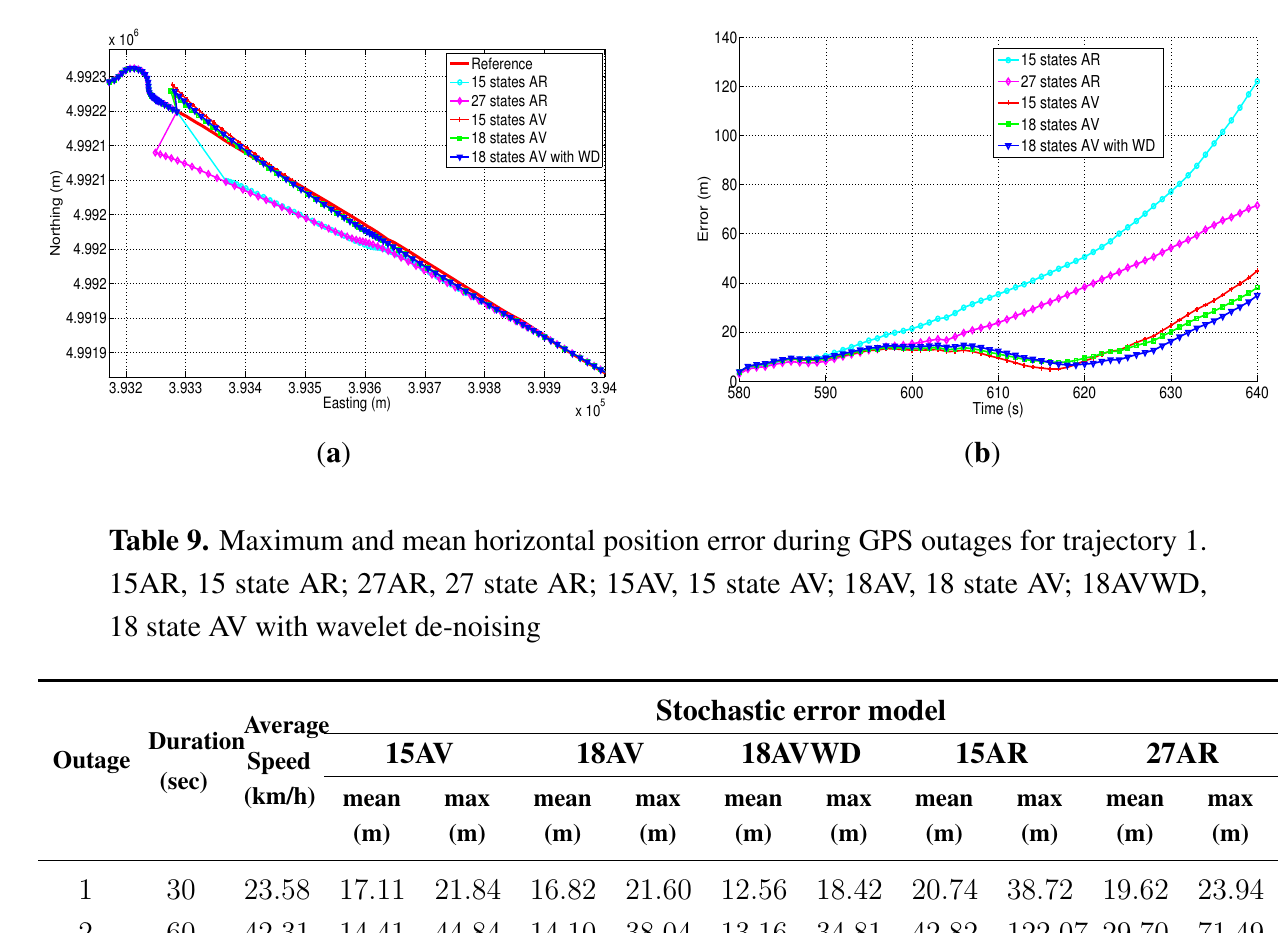
Figure 22. ( a ) Horizontal position during GPS outage 2; ( b ) horizontal position error during GPS outage 2.